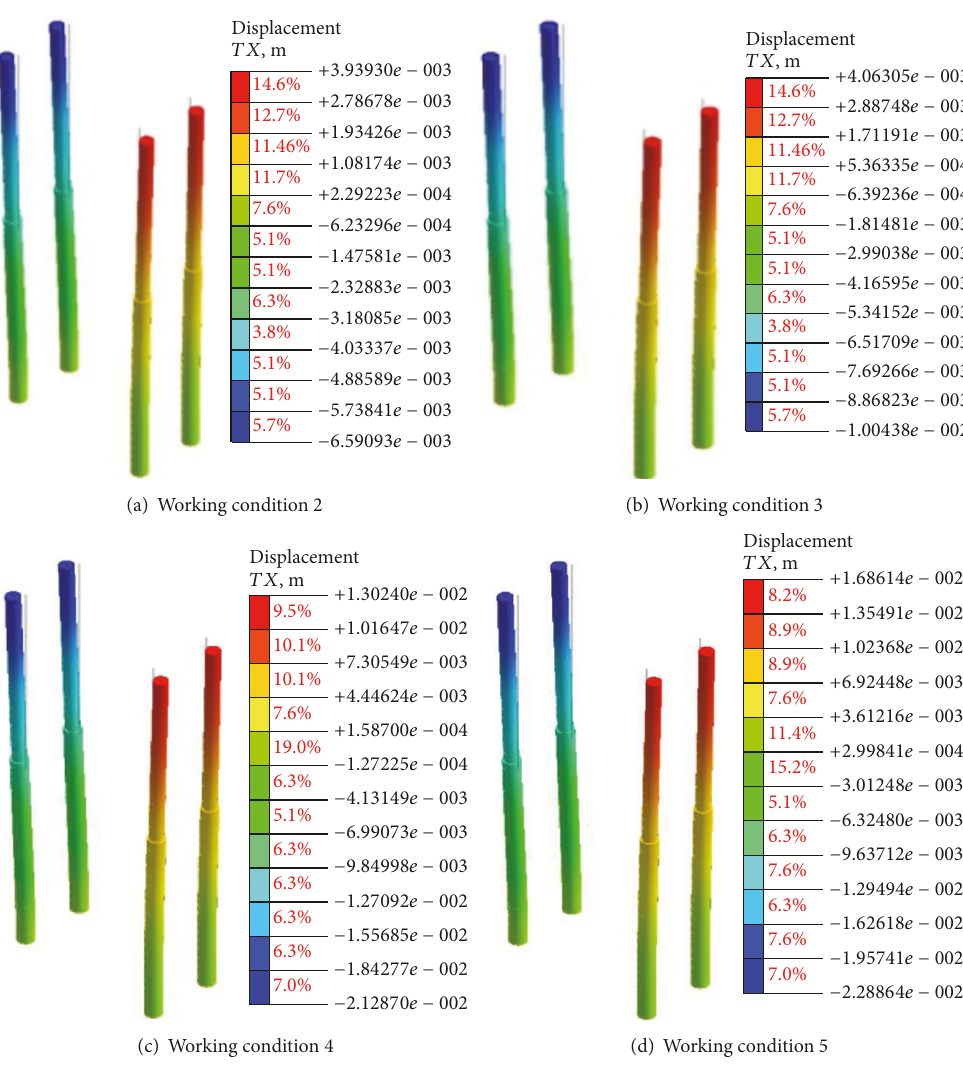
Figure 19: Lateral displacement of bridge piles and columns under different working